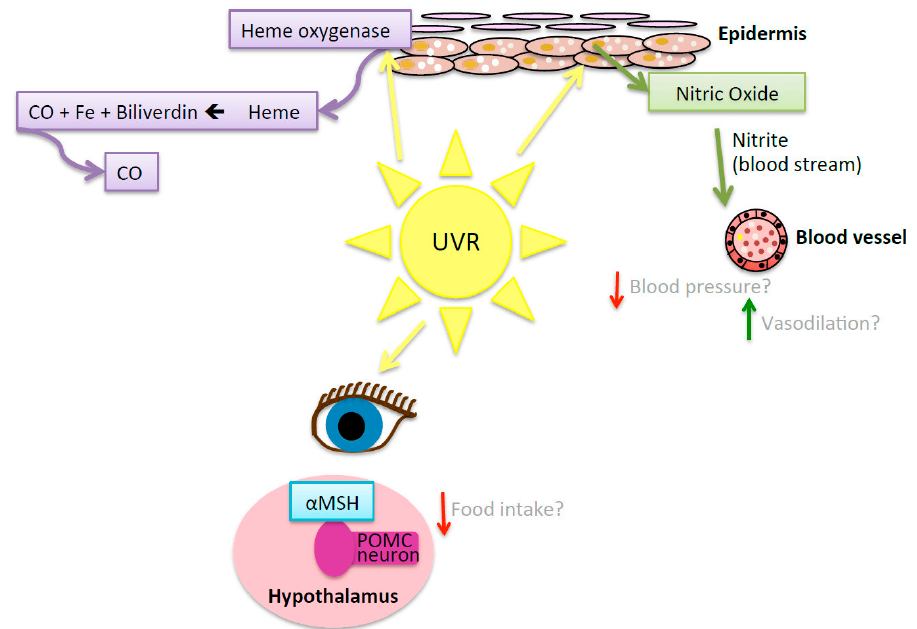
Figure 4. Mediators other than vitamin D are produced or released by exposure to UVR and may play a role in reducing weight gain and signs of cardiometabolic dysfunction. Exposure to ultraviolet radiation (UVR) results in the production of heme oxygenase, which causes the breakdown of heme, catalysing the production of carbon monoxide (CO), iron (Fe) and biliverdin; however, the role of this pathway on the development of obesity and cardiometabolic dysfunction is still to be defined. Nitric oxide stores in skin are released into the blood stream as nitrite potentially reducing blood pressure and increasing vasodilation. When skin and the eye are exposed to UVR there is a release of α -melanocyte-stimulating hormone (MSH), which activates pro-opiomelanocortin (POMC)-responsive neurons in the arcuate nucleus of the hypothalamus, and hypothetically could reduce appetite and food intake.